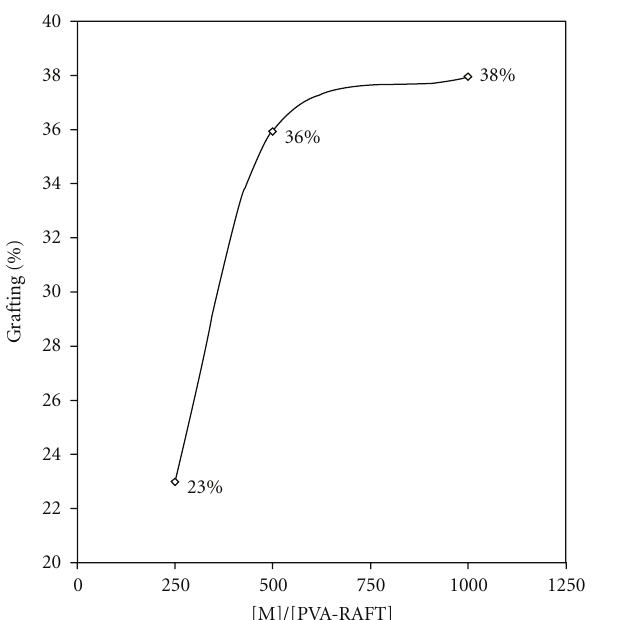
Figure 9: GPC graph of PS.